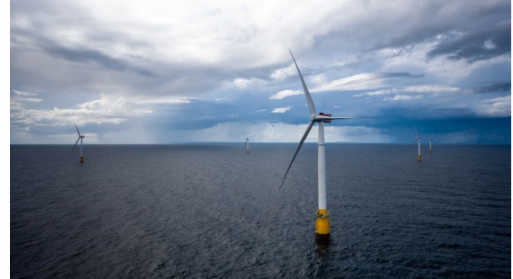
Figure 2. Hywind